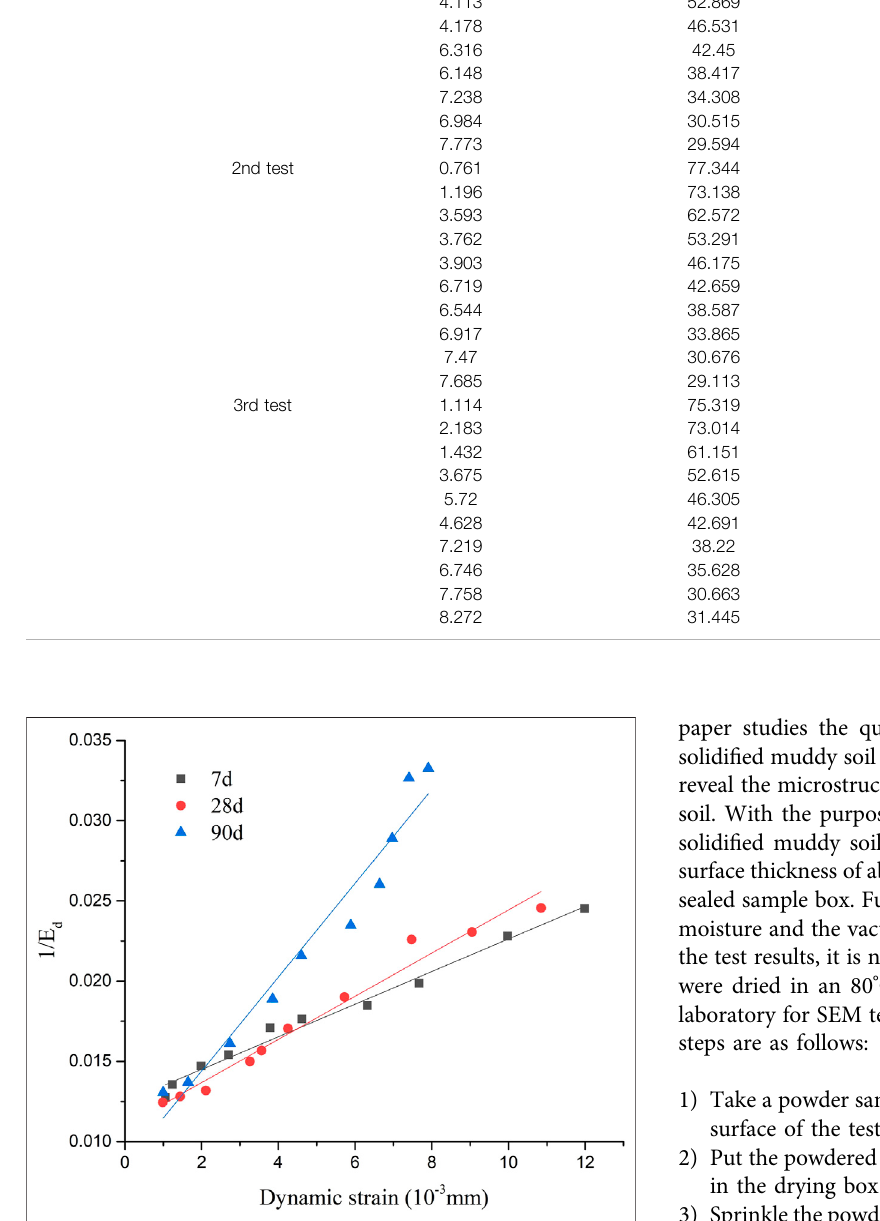
TABLE 6 | ( Continued ) Dynamic elasticity modulus E d of solidi fi ed muddy soil at different curing ages. Curing ages (d)